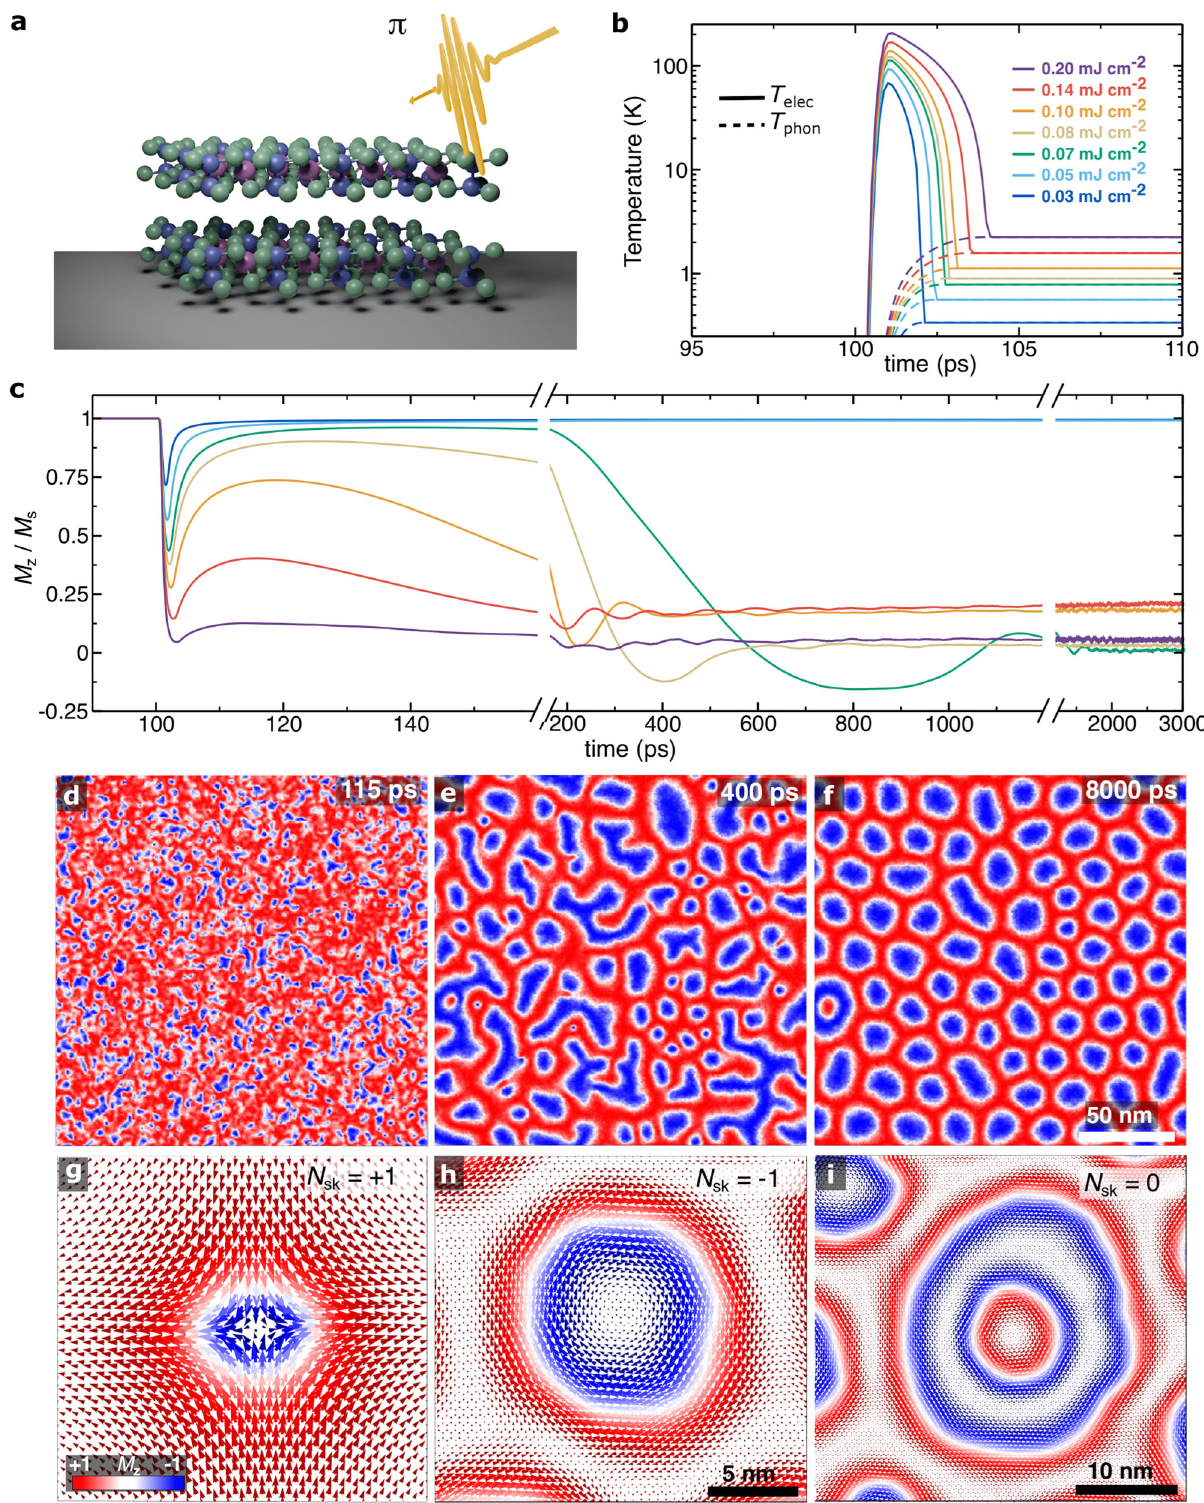
Fig.1|Laser-induceddemagnetisationprocessesandspintextures.a Schematic oftheultrafastlaserpulseswithlinearpolarisation π onCrGeTe 3 . b Evolutionofthe electronic ( T elec ) and phonon ( T phon ) temperatures using the 2TM approach after theapplicationofasinglepulseatdifferentenergy fl uences(mJcm − 2 ). c Variationof the out-of-plane magnetisation M z / M s versus time(ps) atthe fl uences showedin b . Line breakings areused to separate the three regimes observed in the simulations. d – f Snapshots of the spin dynamics ( M z ) following the pulse at 115ps, 400ps, and